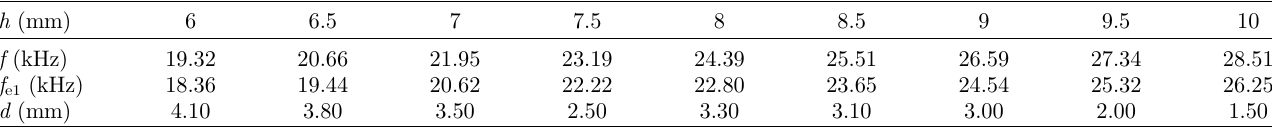
fi rst and eighth nodes (as shown in Fig. 3b) increased, i.e., the nodal lines expanded outside.